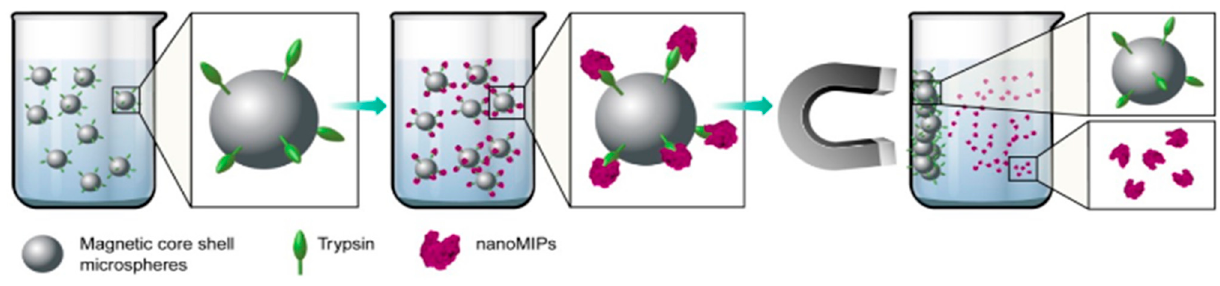
Figure 5. MIP solid-phase synthesis employing magnetic nanoparticles. Trypsin is immobilized on silica-coated magnetic nanoparticles prior to the synthesis. Reproduced with permission [72] © 2021 © The Royal Society of Chemistry .